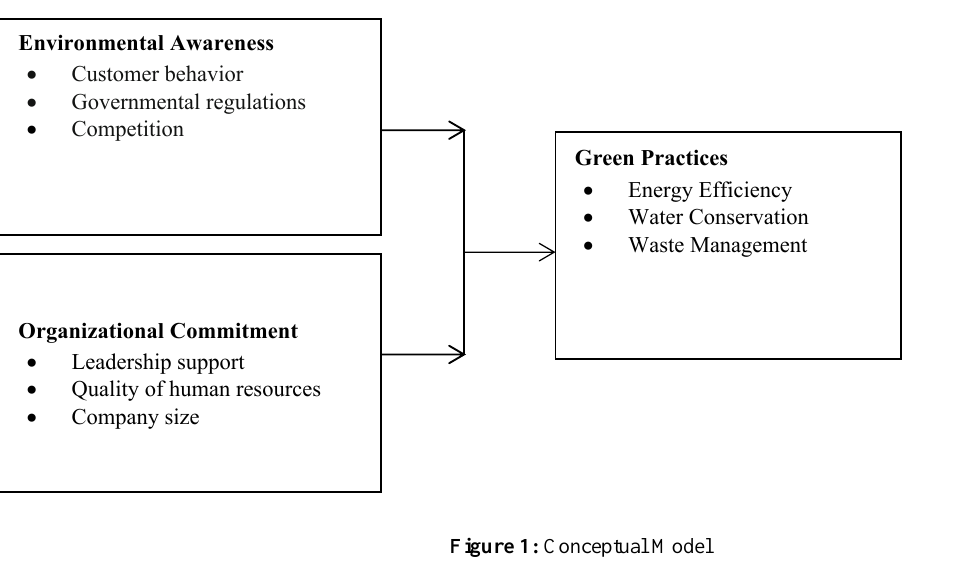
Figure 1 deliniates the conceptual model of the study: